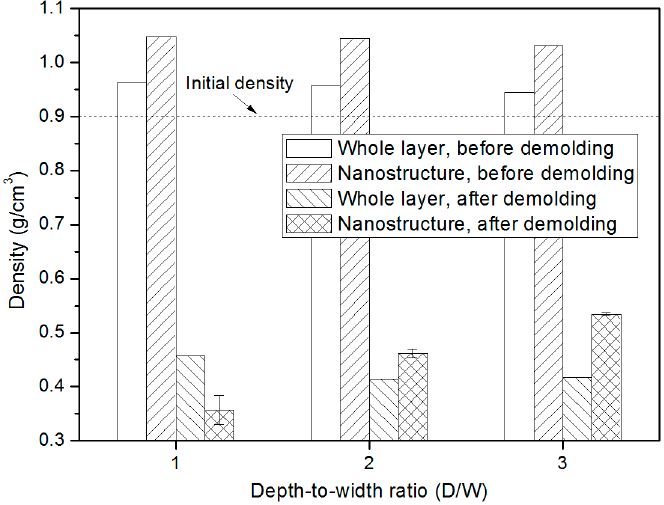
Figure 5. Densities of the whole PP layer and the PP nanostructure with different D/W, compared with the density values before and after demolding.